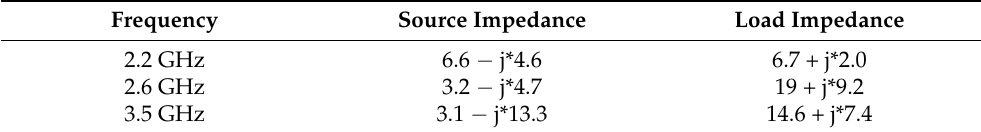
Table 1. Load impedance and source impedance.